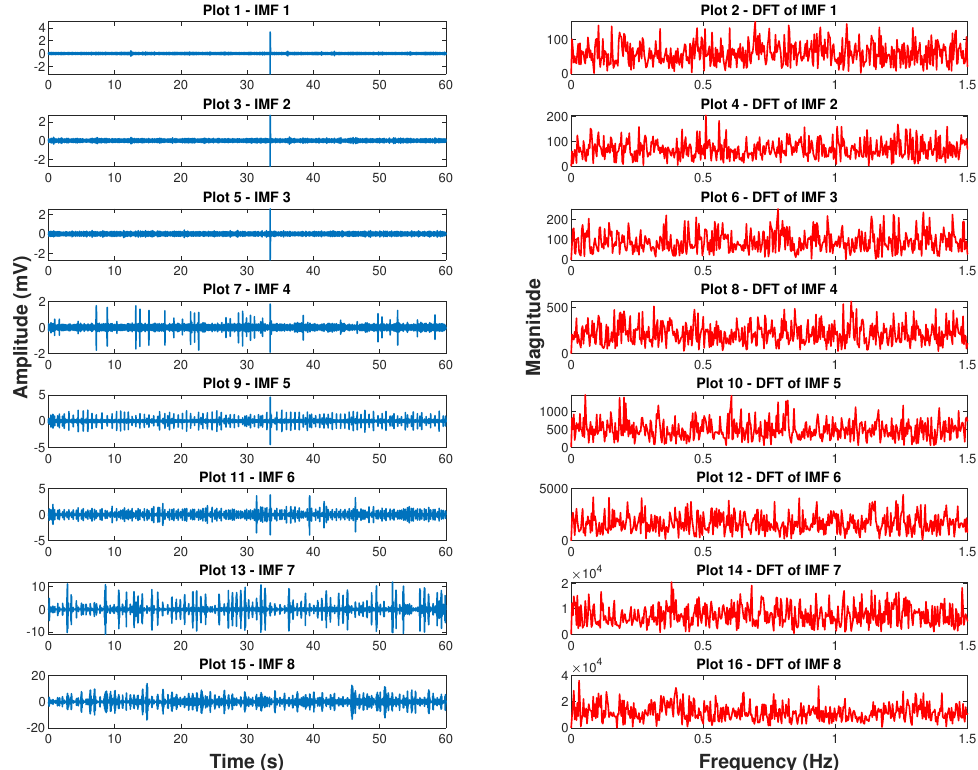
Figure 2. DFT analysis of the IMFs 1 to 8 of b001: The plots on the left column depict IMFs 1 to 8. The plots on the right column show the corresponding spectra (DFT points =